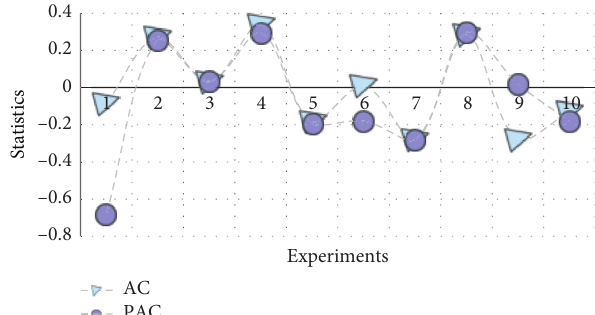
Figure 7: Autocorrelation coefficient and partial autocorrelation coefficient of GDP